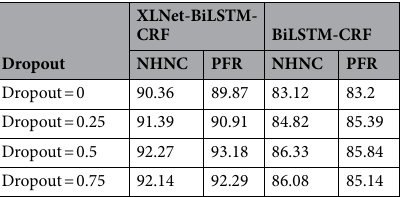
Table 6. The influence of different dropout on the performance of the